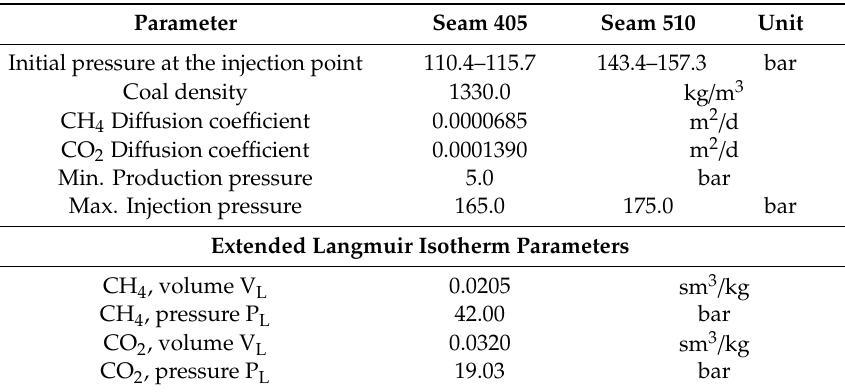
Table 4. Details of the reservoir simulation